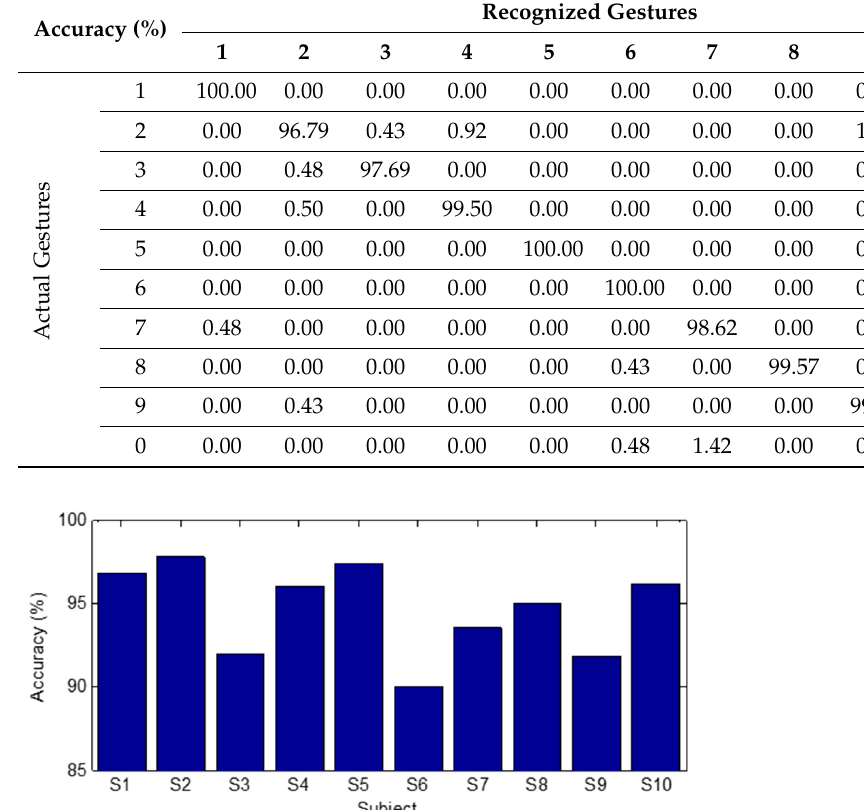
Table 7. Confusion matrix of Test A in gesture recognition experiment.